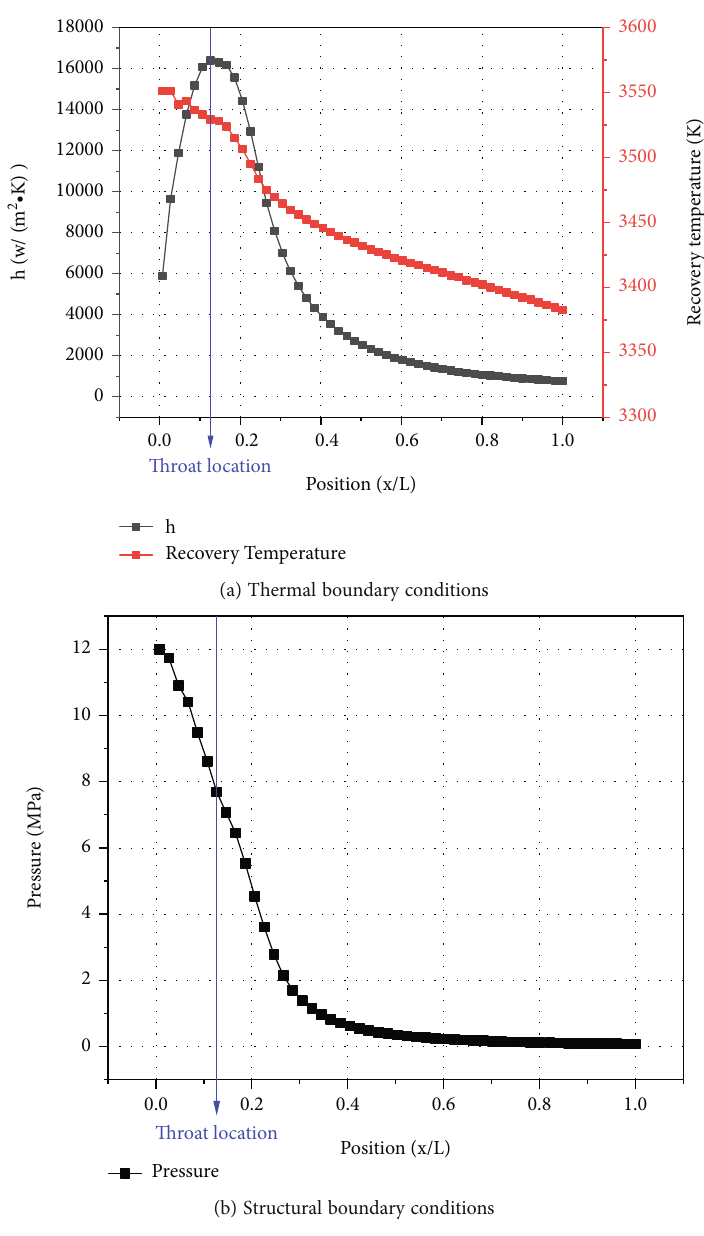
Figure 5: Thermo-structural